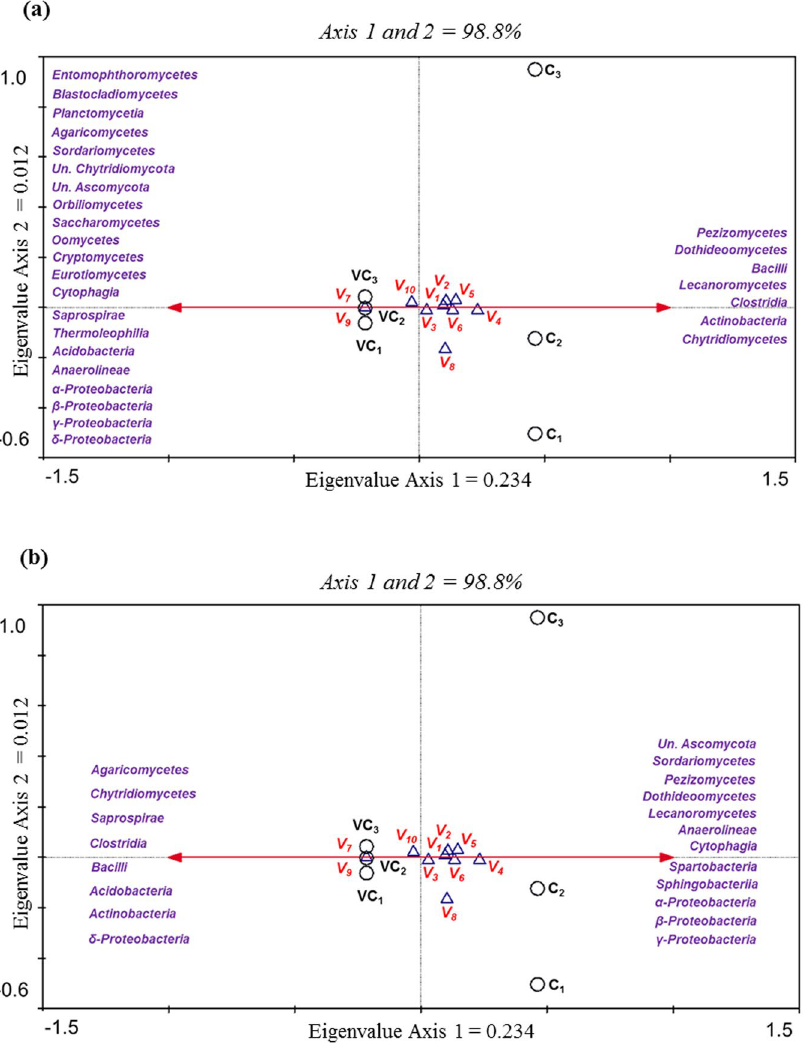
Figure 6. CCA triplot analysis of volatiles emitted by Nerium oleander plants grown in a potting soil initially containing a sterile (C: Control)/non sterile (VC: Vermicompost) inoculum and after attack by Aphis nerii . Arrows indicate the orientations of total ( a ) and active ( b ) rhizosphere microbiome. V 1 : 4-methoxy- benzaldehyde,